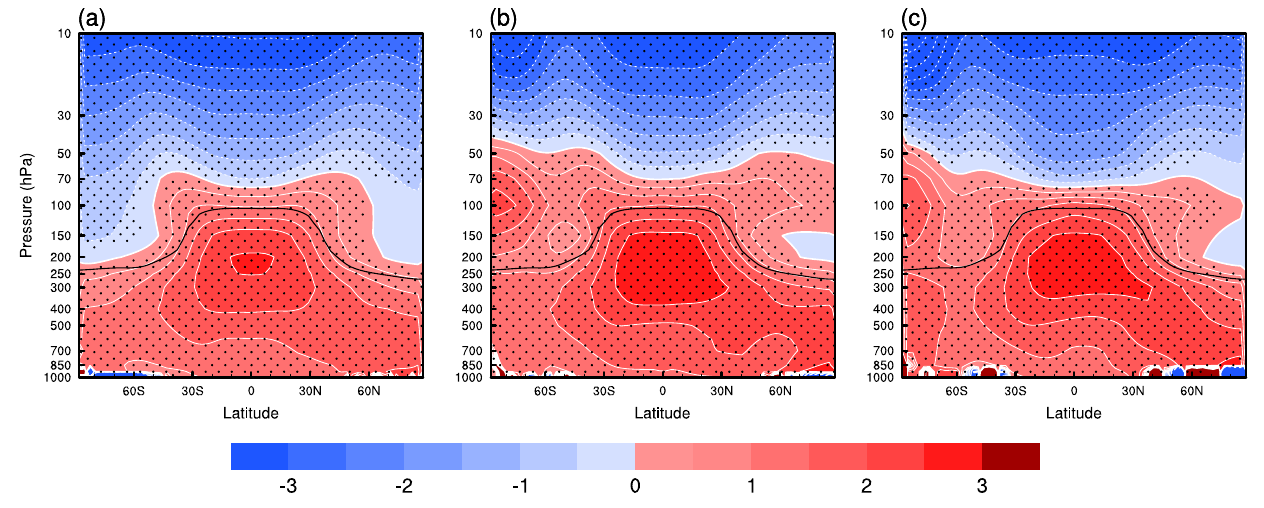
Fig. 5. Annual and zonal mean temperature trends over 2001–2050 for (a) AR4-O 3 , (b) AR4-NO-O 3 and (c) CCMVal-1-1 models. Colour interval is 0.5K per 50 years, pink: positive, and blue: negative. Black lines in the plots indicate the climatological positions of the tropopause. Regions with dots are the places where trend differences have statistical significant levels higher than the 95% confidence level (student t-test values are greater than 2.0). In the following figures, dots have the same indication of statistical significance for temperature trends and trend differences.